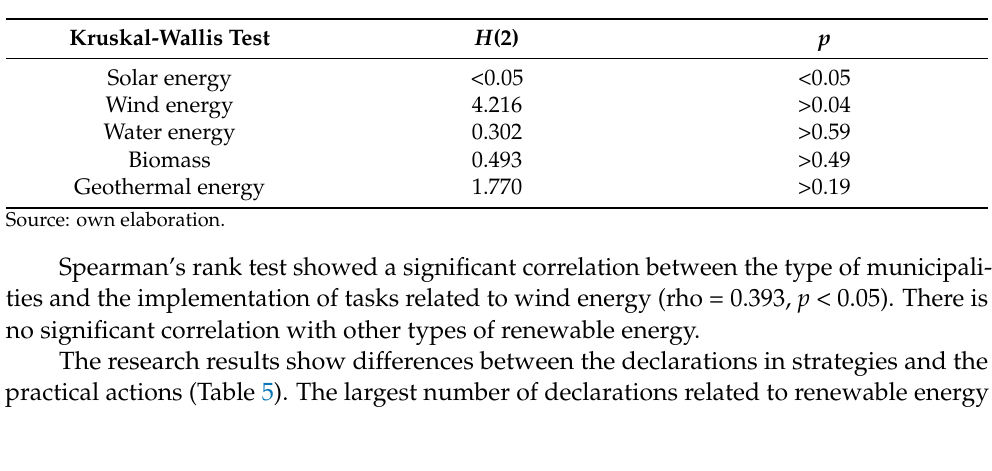
Table 4. Kruskal-Wallis tests for the type of renewable energy in Cittaslow network vs. categories of municipalities by